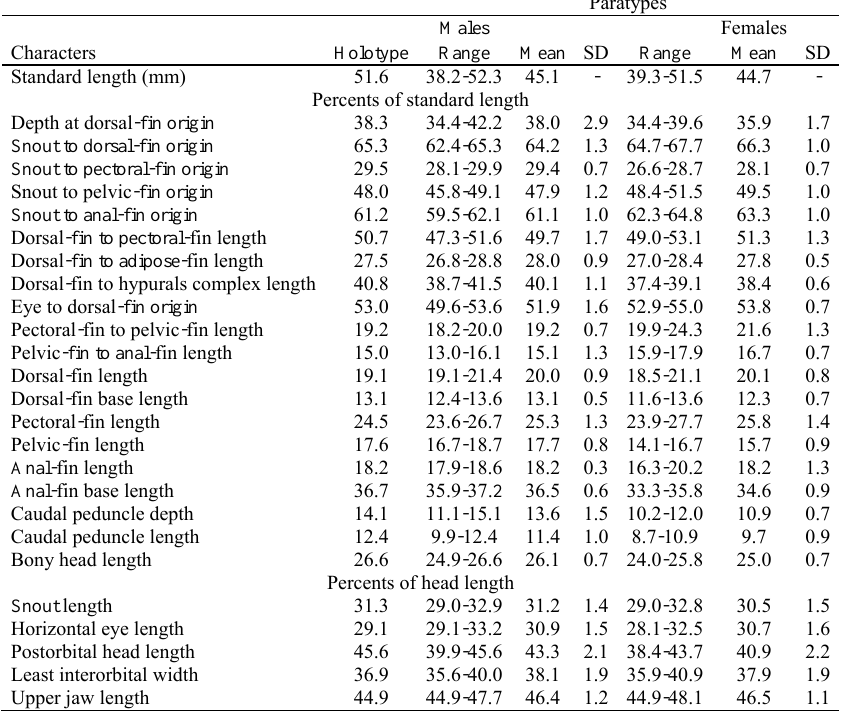
Table 1. Morphometric data of holotype and 12 paratypes of Chrysobrycon yoliae (five males and eight females) from an unnamed Quebrada, río Yucamia system, Ucayali basin, Peru. SD = standard deviation. The values of the holotype are included in the range of